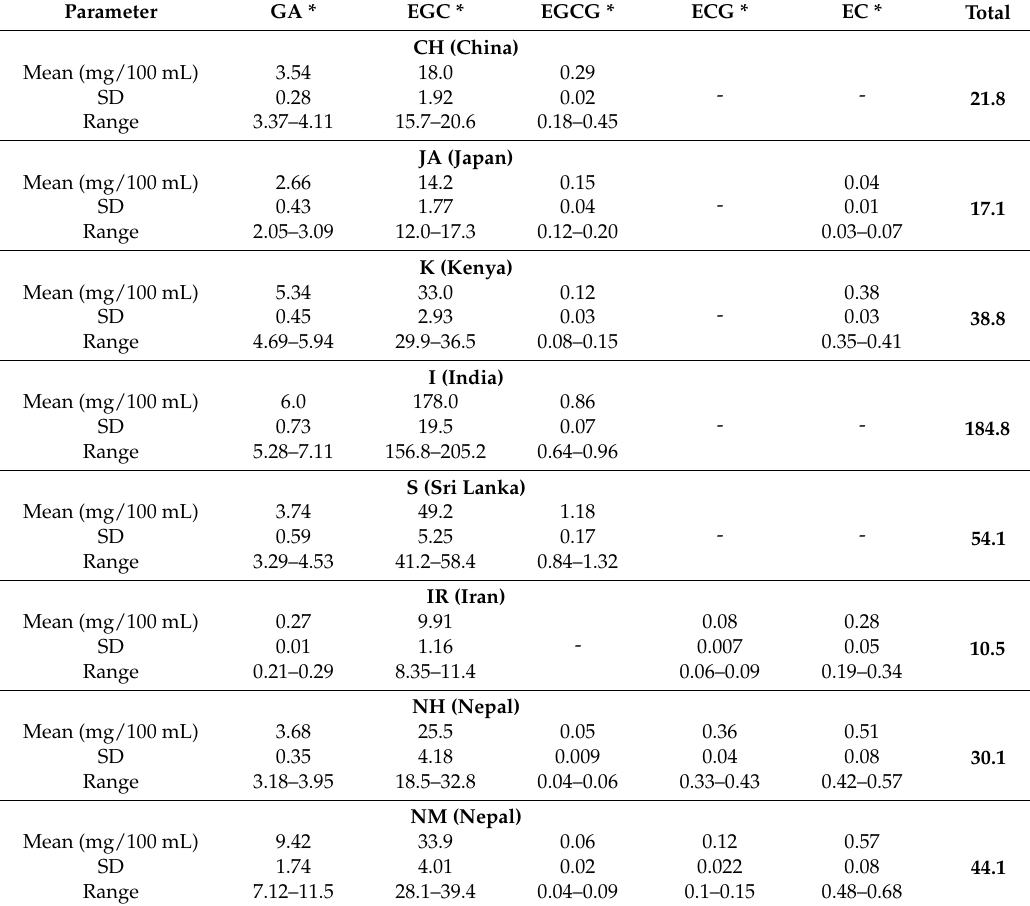
Table 1. The content of gallic acid and catechins in the black